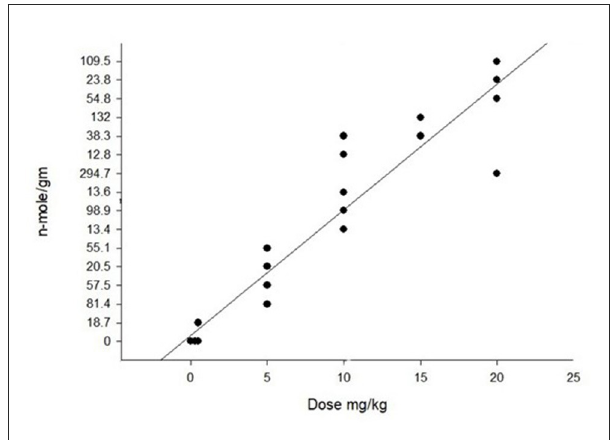
FIGURE12 Graph of pyrrole (dehydropyrrolizidine alkaloid metabolite) concentration in the liver of pigs that were dosed with purified riddelliine. As seen with the regression there is a positive correlation with dose that was significant with r 2 = 0.90. Pyrrole analysis was done following previously described techniques (4). Similar positive correlations of pyrrole concentrations with PA dose have been seen in other species with variations relating duration and recovery time. Modification of previously reported data